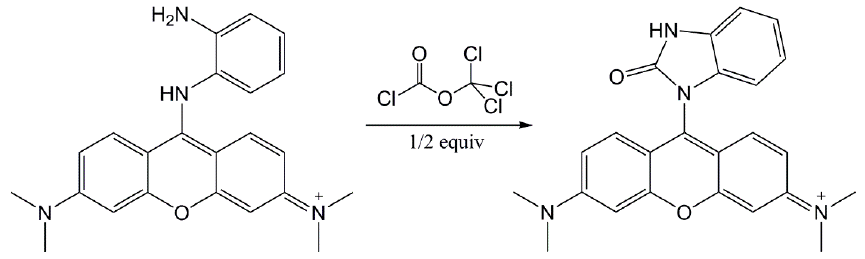
Figure 3. The o -phenylendiamine-pyronine (PY-OPD) reaction scheme with diphosgene (DP) (modified according to Reference [11]).